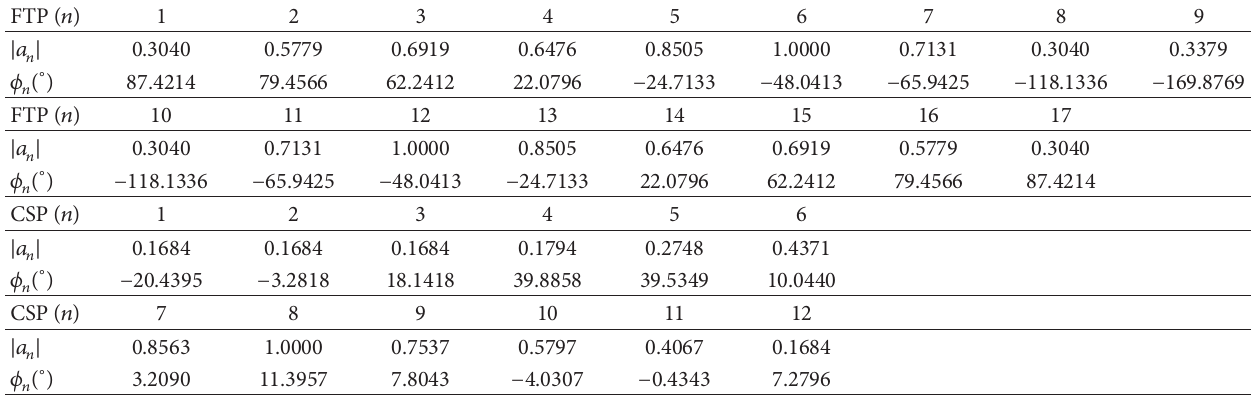
Table 2: Excitations for our synthesised FTP and CSP patterns.